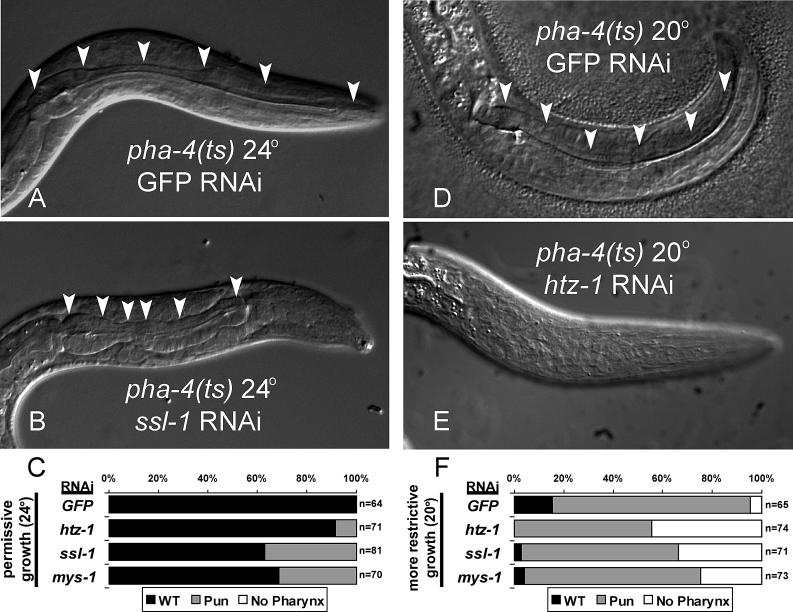

mys-1, ssl-1, and htz-1 Enhance Pharyngeal Defects of pha-4(ts)
(A–C) Feeding dsRNA to pha-4(ts) worms at the permissive temperature of 24 °C.(A) A pha-4(ts); GFP(RNAi) L1 with a wild-type pharynx (arrowheads).(B) A pha-4(ts); ssl-1(RNAi) L1 with an unattached pharynx (arrowheads).(C) Quantitation of pha-4(ts) animals exhibiting a normal pharynx (WT), an unattached or incomplete pharynx (Pun), or no detectable pharynx. htz-1, ssl-1, or mys-1 RNAi significantly increased the number of Pun pha-4(ts) animals (htz-1: p=0.0290; ssl-1 and mys-1: p < 0.0001, Fisher exact test).(D–F) Feeding dsRNA to pha-4(ts) animals at the intermediate temperature of 20 °C.(D) A pha-4(ts); GFP(RNAi) L1 at the intermediate temperature of 20 °C with a morphologically wild-type pharynx (arrowheads).(E) A pha-4(ts); htz-1(RNAi) worm at 20 °C missing a detectable pharynx.(F) Quantitation of pha-4(ts) animals exhibiting a normal pharynx (WT), an unattached or incomplete pharynx (Pun), or no detectable pharynx. htz-1, ssl-1, or mys-1 RNAi significantly increased the number of worms with no detectable pharynx (htz-1 and ssl-1: p < 0.0001; mys-1: p = 0.0015; Fisher exact test). WT worms with reduced htz-1, ssl-1, or mys-1 activity had a wild-type pharynx at 24 °C and 20 °C (unpublished data). RNAi was conducted by feeding dsRNA [29].